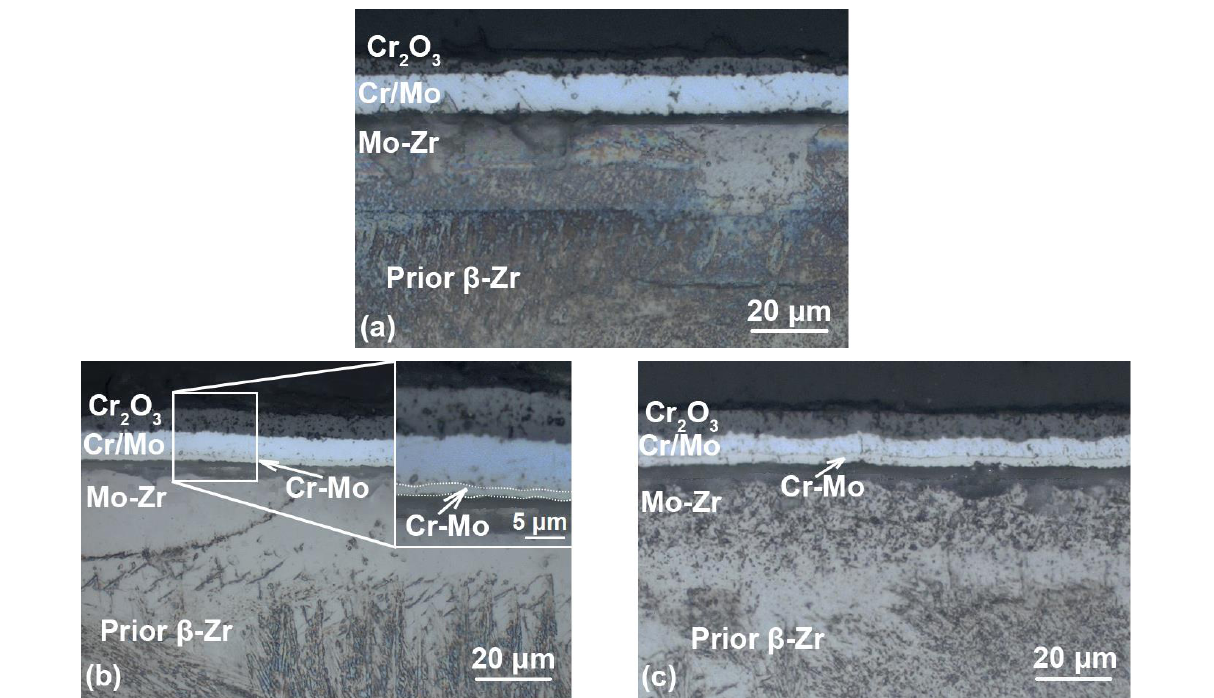
Figure 5. Cross-section optical micrographs of Cr/Mo-coated Zr alloy samples after oxidation at 1330 °C for 120 s ( a ), 300 s ( b ), and 720 s ( c ). Oxidation at 1400 °C. A significant change in the microstructure is observed after oxidation at 1400 °C (Figure 6). The oxide layers consisted of outer columnar ZrO 2 , and oxygen- stabilized α -Zr(O) phases were formed. The formation of such layers was also observed during oxidation of the uncoated and Cr-coated Zr alloy in steam at 1400 °C for 120 s in [27]. For the Cr/Mo-coated Zr alloy, the thickness of the ZrO 2 oxide layer was ~2.5 and 2 times lower compared to the uncoated and Cr-coated samples. This fact indicates a short-term effect of the barrier Mo sublayer at 1400 °C. Previously, it was shown that a green Cr 2 O 3 oxide was observed on the surface of the Cr/Mo-coated Zr-1Nb (Table 4), but this layer is not present on the OM image. This is because the Cr 2 O 3 oxide layer has a small thickness, which is not resolved in the optical image. Based on the elemental composition, the sample microstructure is also represe nted by an α -Zr(O) layer enriched with Cr and Mo and an Cr-Zr interdiffusion layer. The formation of Cr-enriched areas is explained by the rapid Cr diffusion into the Zr alloy due to oxidation of Cr 2 Zr to Cr and ZrO 2 [25].